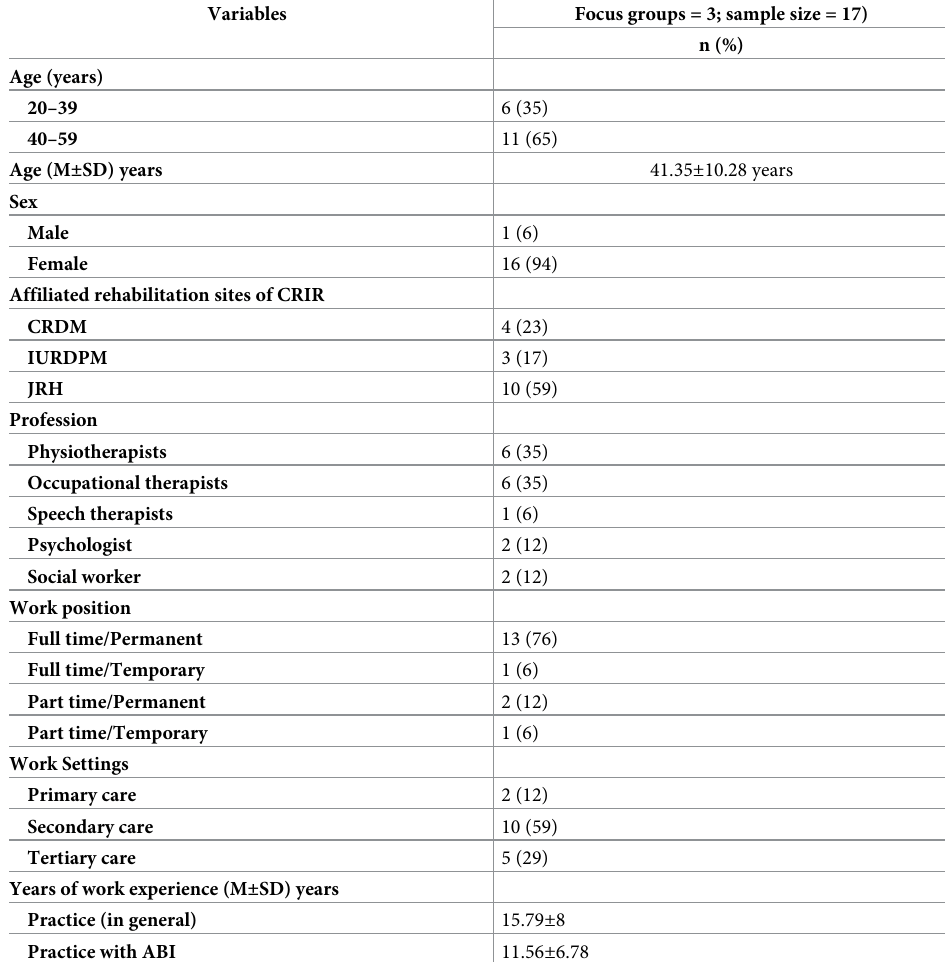
Table 1. Characteristics of